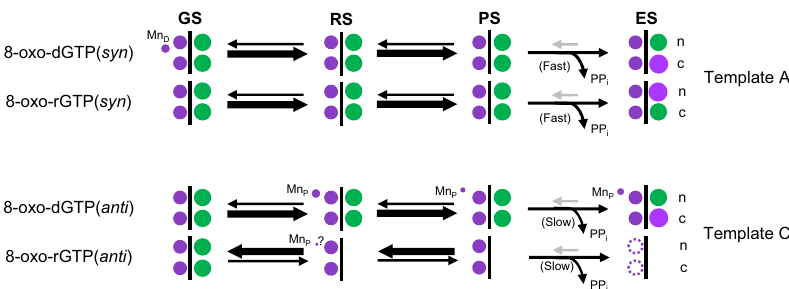
Fig. 6 Active site metal modulation of ribo- and deoxy-8-oxo-GTP discrimination opposite adenine and cytosine. Equilibrium between the ground (GS), reaction (RS), product state (PS) and extended soak (ES) intermediates during 8-oxo-dGTP and 8-oxo-rGTP insertion opposite A t and C t is shown. Thick and thin arrows indicate stronger and weaker preference for the given direction of reaction (forward or reverse), respectively. The smaller magenta and green circles depict the active site Mn 2 + and Mg 2 + atoms, respectively, while the larger purple spheres are Na + atoms. Dashed circles indicate intermediates yet to be observed. The letters to the right denote the catalytic (c) and nucleotide (n) metals. The third smaller magenta circle indicates observation of Mn p or Mn D . PP i release is either “ slow ” or “ fast ” and is shown as a curved arrow, while a grey arrow indicates the possibility of PP i